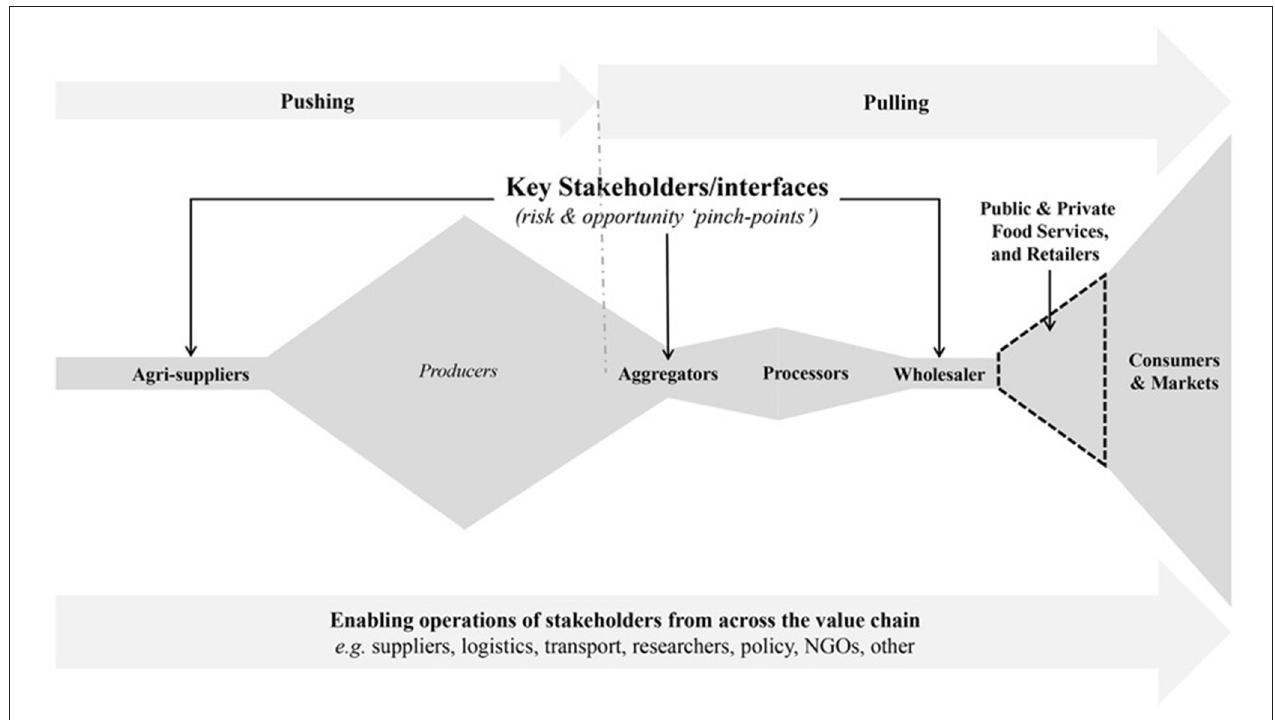
FIGURE 2 | Adapted from the TRUE-Project WP4 Deliverable of Hamann et al. (2018), the schematic value chain pattern shown here is commonly associated with modern large-scale industrialized feed- and food-based value chains. It highlights “pushing” and “pulling” segments, and specific “key stakeholder” groups, and downstream stakeholder-interfaces to help drive positive transformative food-system change. While the number of “Key Stakeholders” is relatively low at specific value-chain segments (or, “pinch-points”) and may reinforce risks and impacts of current lock-ins, the same “pinch-points” also offer focal groups of value chain control and transformation toward new and more-sustainable